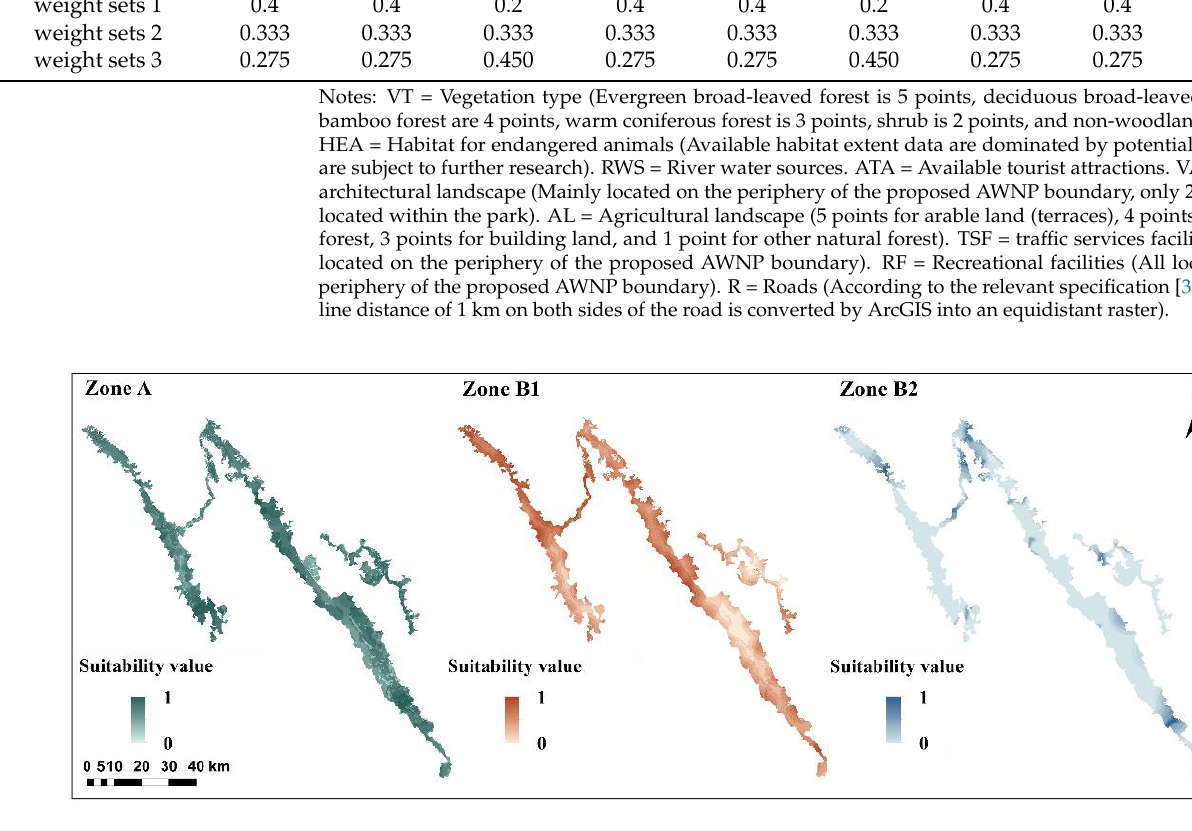
Figure 5. Landscape unit suitability maps for Zones A, B1, and B2. 2.3.3. Spatial Multi-Target Units Allocation Considering that the proposed AWNP is a fragmented spatial distribution, we use k- means++ for the multi-target unit's allocation. It allows for a greater concentration of sim- ilar landscape units at spatial distances [37]. Firstly, the suitability atlas was obtained by applying the average of all fishing net points in each landscape unit. The average between the top 50% and the average between the top 30% were used as input elements. This was followed by a comparison of the results of the selection of the three functional divisions. When landscape units are selected for only one functional partition, they are assigned directly to that partition, while units selected for two or three functional partitions and units not selected by any partition are noted as “ conflicting units ” [22]. Through the above process, three sets of conflicting analyses of landscape unit allocations based on different mean values were completed (Figure 6).